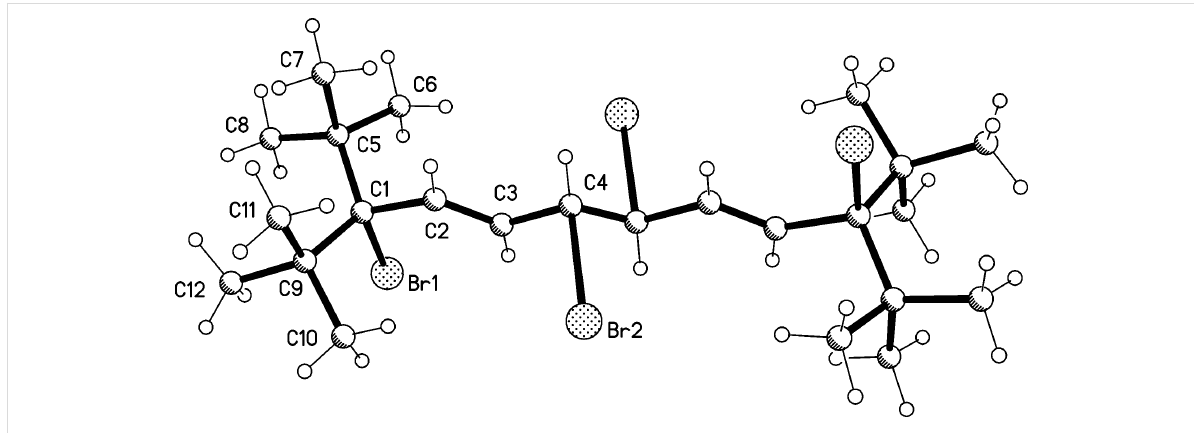
Figure 3: The structure of compound 25 in the crystal. This was a structure of poor quality and served only to determine the connectivity.